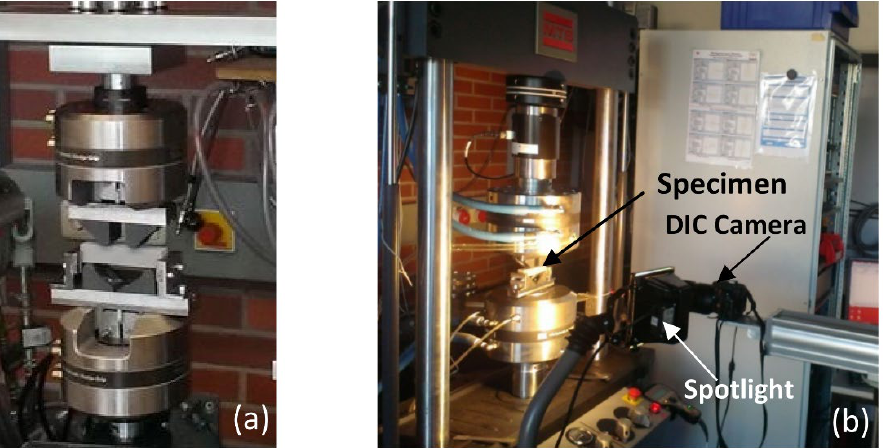
Figure 4. ( a ) Lattice sample mounted on the FPB test machine before the beginning of the test; ( b ) Experimental test setup accompanied by DIC.